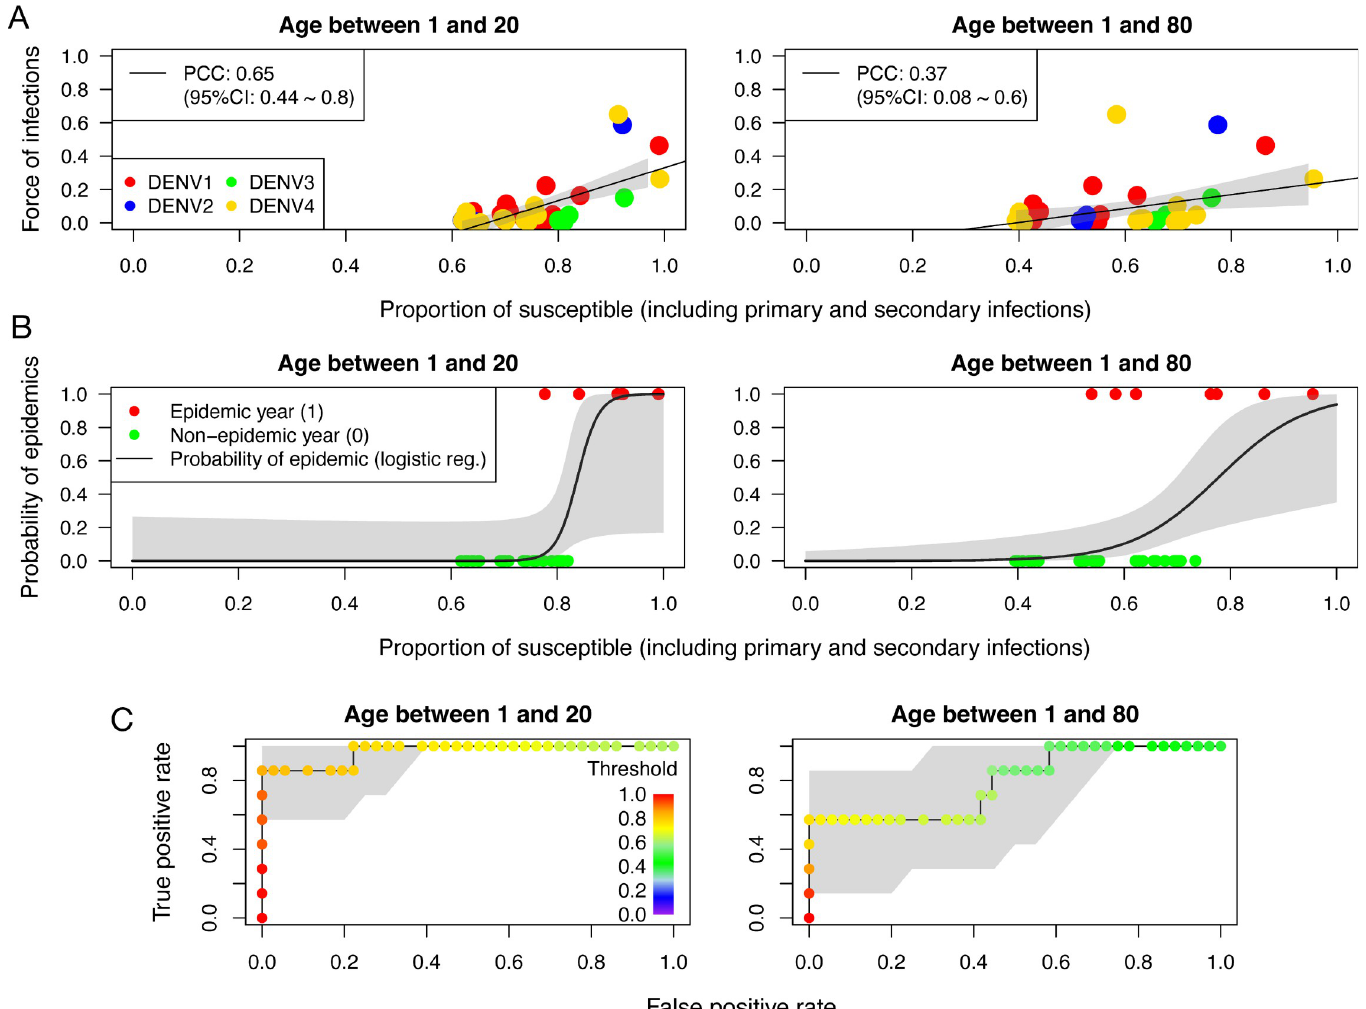
Fig 5. Relation between the proportion of susceptibles and FOI (obtained from our model). (A) FOI as a function of the fraction of the susceptibles to primary and secondary infections for children (left panel) and general population (right panel). Different colours represent a different circulating serotype. The black solid lines represent the linear regression to the data with 95%-CI as grey shaded areas. Pearson correlation coefficient (PCC) between the FOI and the fraction of the susceptible is also provided in the figure. (B) The probability of occurrence of an epidemic (black solid lines) as a function of the fraction of susceptibles. This probability is estimated using application of the logistic regression to the data (See Materials and methods Section). Grey shaded areas show 95%-CI. Red and green circles show epidemics and non-epidemic time periods, respectively. (C) ROC curve to illustrate the diagnostic ability of predicting an epidemic using the fraction of the population that are